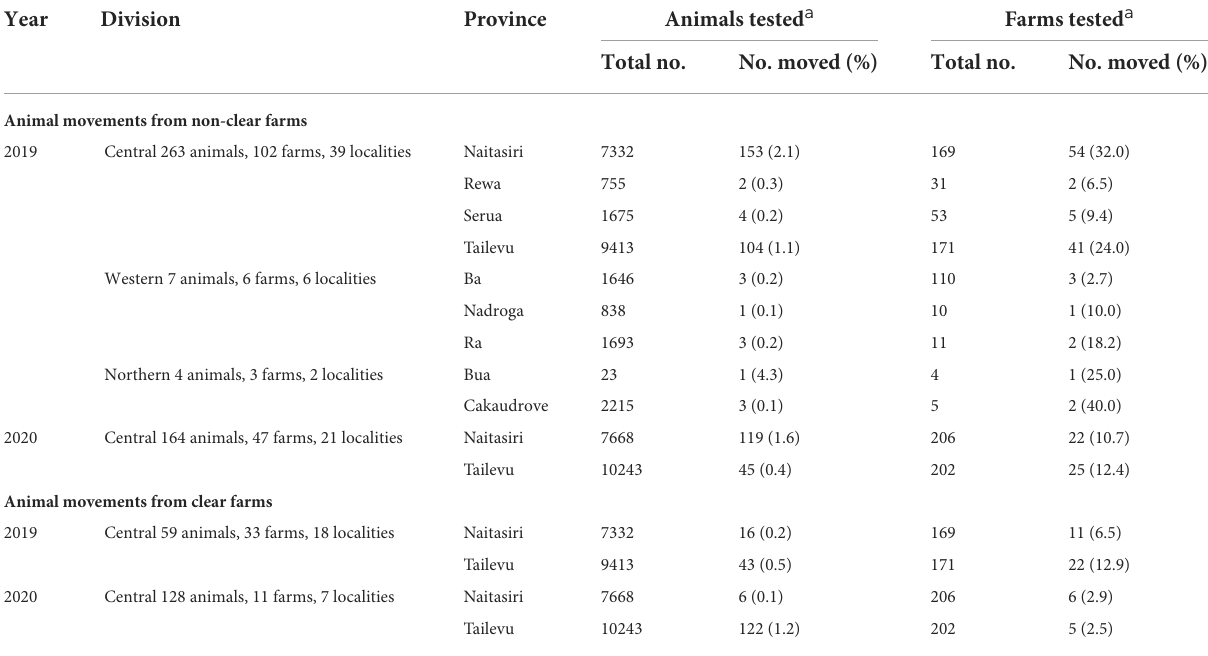
TABLE 9 Animal movements from non-clear farms to a farm in the same province and from clear farms to a farm in the same province during 2019-2020. Division